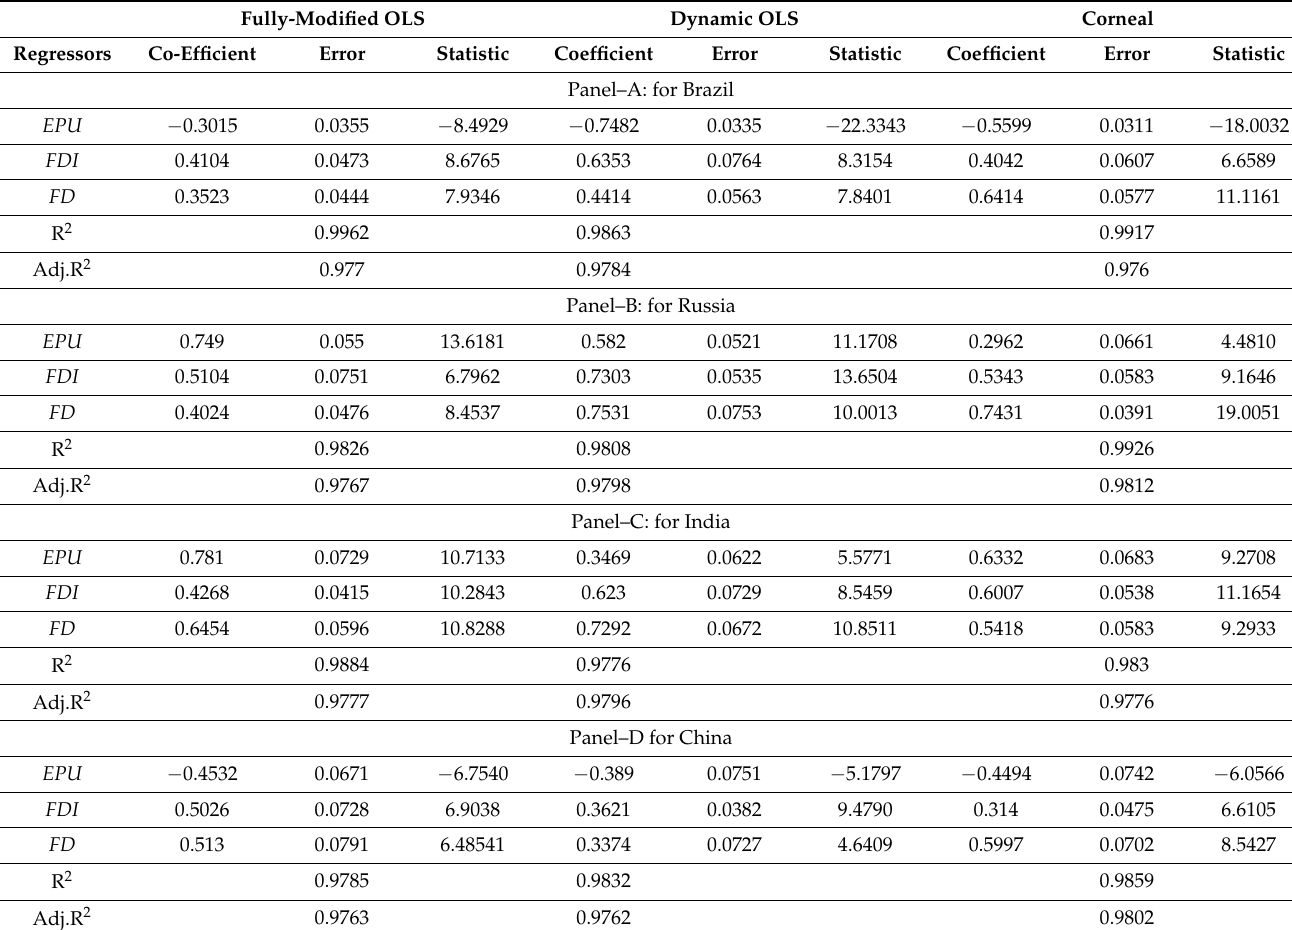
Table 11. Robustness